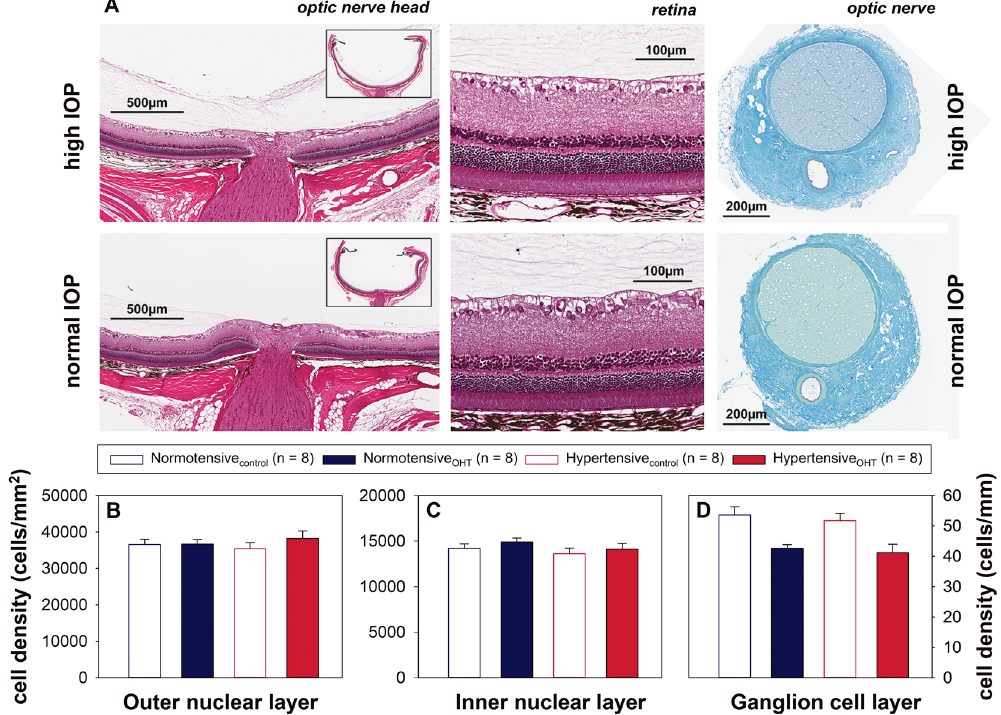
Figure 6. Effect of chronic IOP elevation on retina and optic nerve structure in normotensive and hypertensive rats. ( A ) Representative images from OHT and control eyes of a rat including sagittal section of optic nerve head and posterior eye cup (inset), retina and coronal. ( B ) Cell density (mean ± SEM) in the outer nuclear layer. ( C ) Cell density (mean ± SEM) in the inner nuclear layer. ( D ) Cell density (mean ± SEM) in the ganglion cell layer. (OHT: ocular